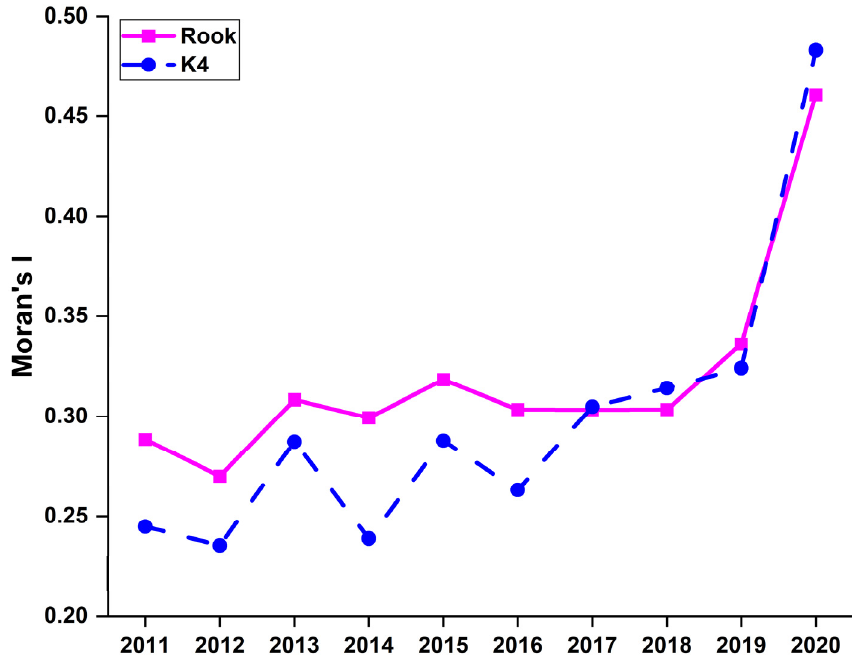
Figure 6. Moran’s I values with Rook and K4 matrices from 2011 to 2020.